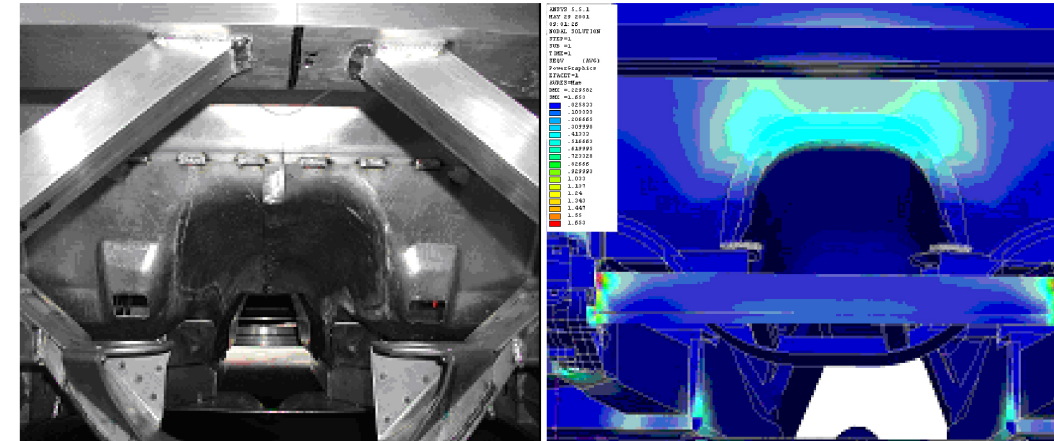
Figure 1. Car frame under analysis and FEM analysis results.